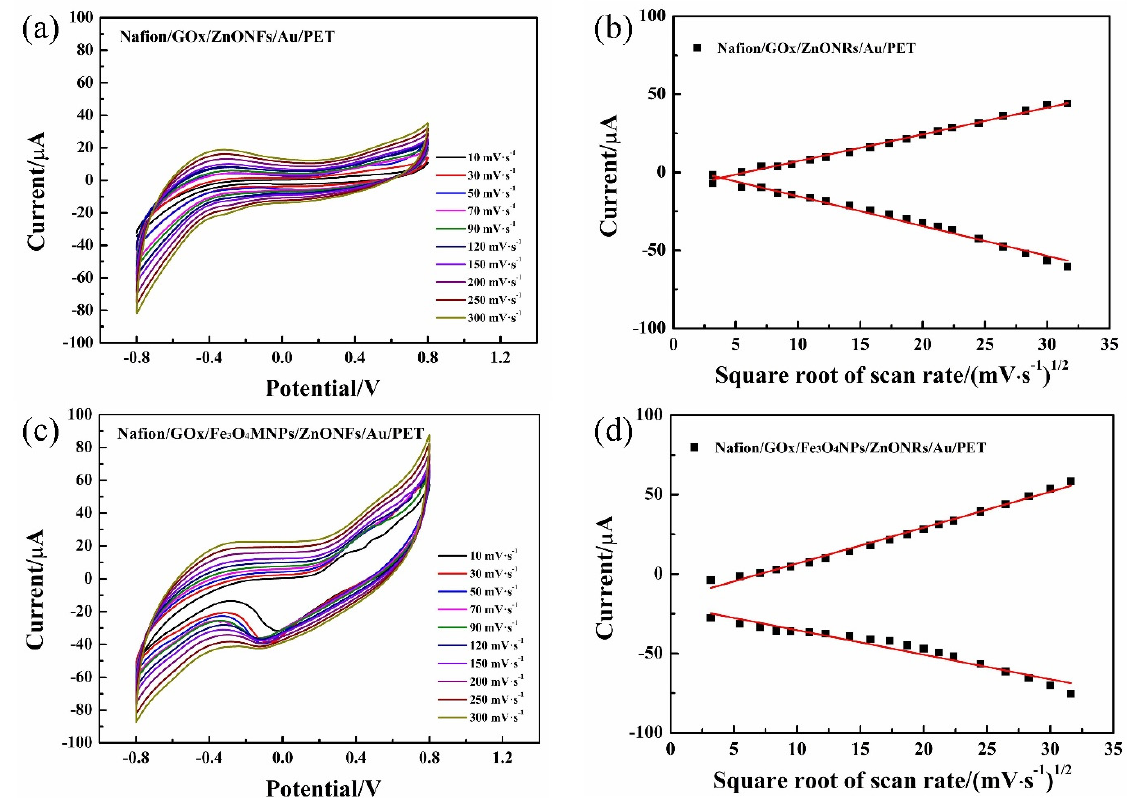
Figure 5. ( a ) The CV curve of the ZnONFs/Au/PET electrode. ( b ) Linear fitting curves of redox current and the square root of scanning rate of glucose ZnONFs/Au/PET electrode. ( c ) Fe 3 O 4 MNPs modified electrode in 3 mM glucose solution. ( d ) Linear fitting curves of redox current and the square root of scanning rate of Fe 3 O 4 MNPs modified electrode.